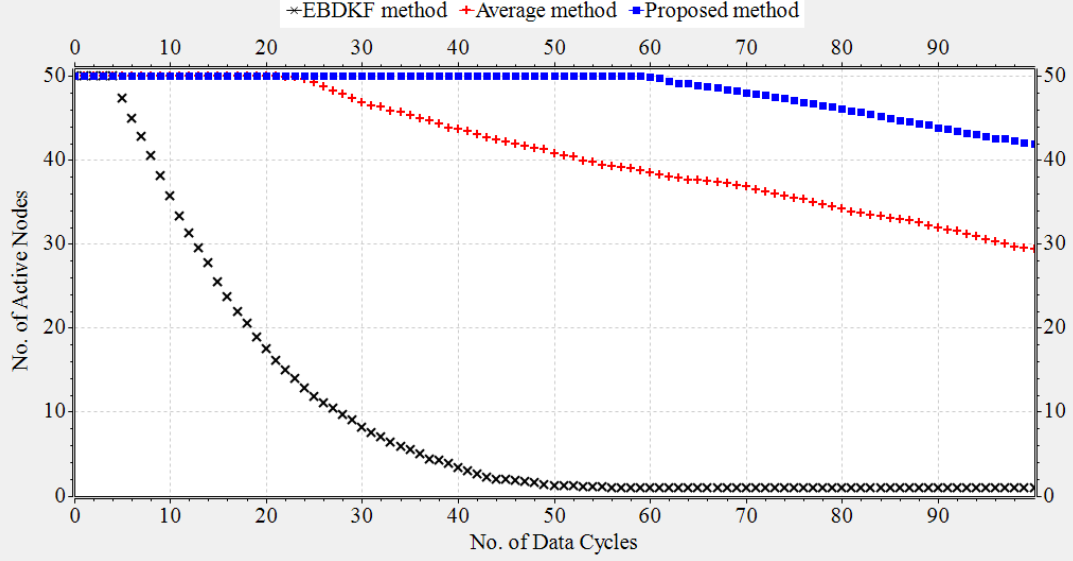
Figure 11. Network lifetime comparison with the proposed statistical, EBDKF and AVG information fusion methods when BER = 0.05 in a chain-based IoT